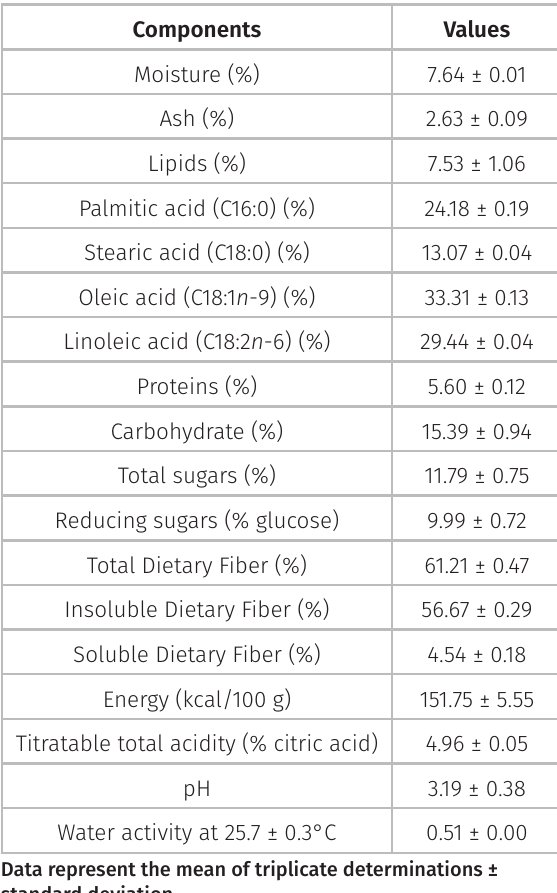
Table I. Physicochemical composition of umbu ( Spondias tuberosa Arr. Cam.) processing waste